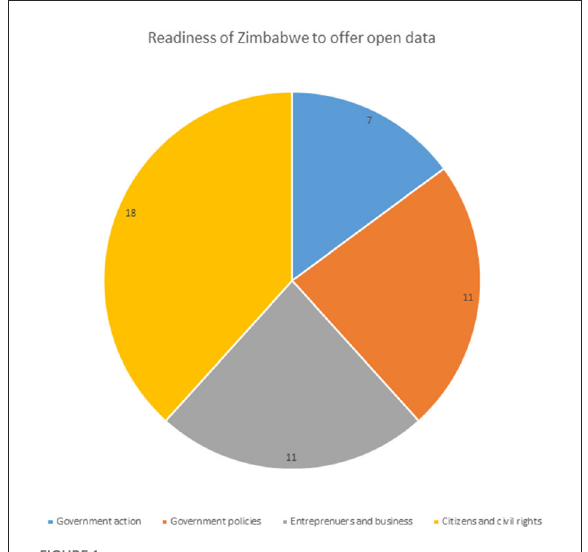
FIGURE1 Readiness of Zimbabwe to offer open data–Data Source, Web Foundation